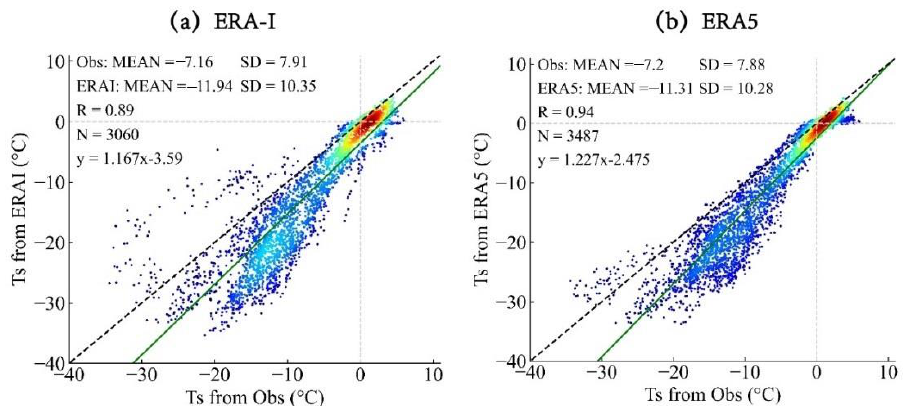
Figure 7. Scatter plots of the daily mean Ts from ( a ) ERA-I and ( b ) ERA5.